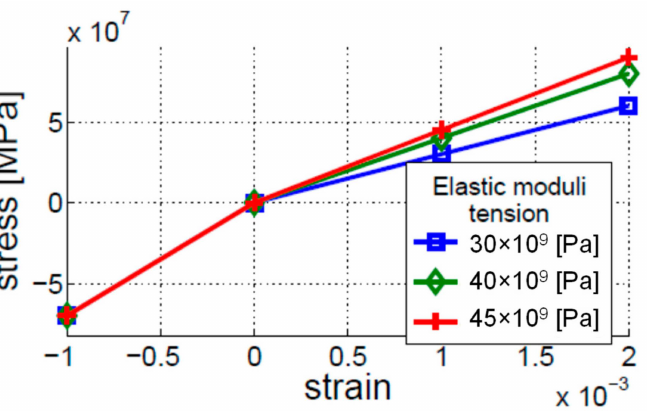
Figure 3. Stress–strain relations applied for the bi-linear model of elasticity for three different crack depths